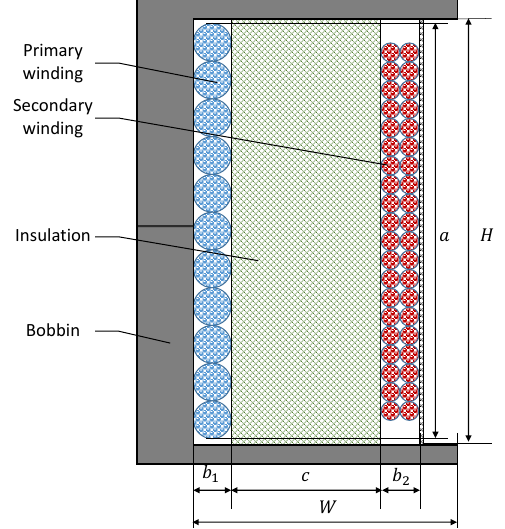
Figure 4. Transformer with thick insulation